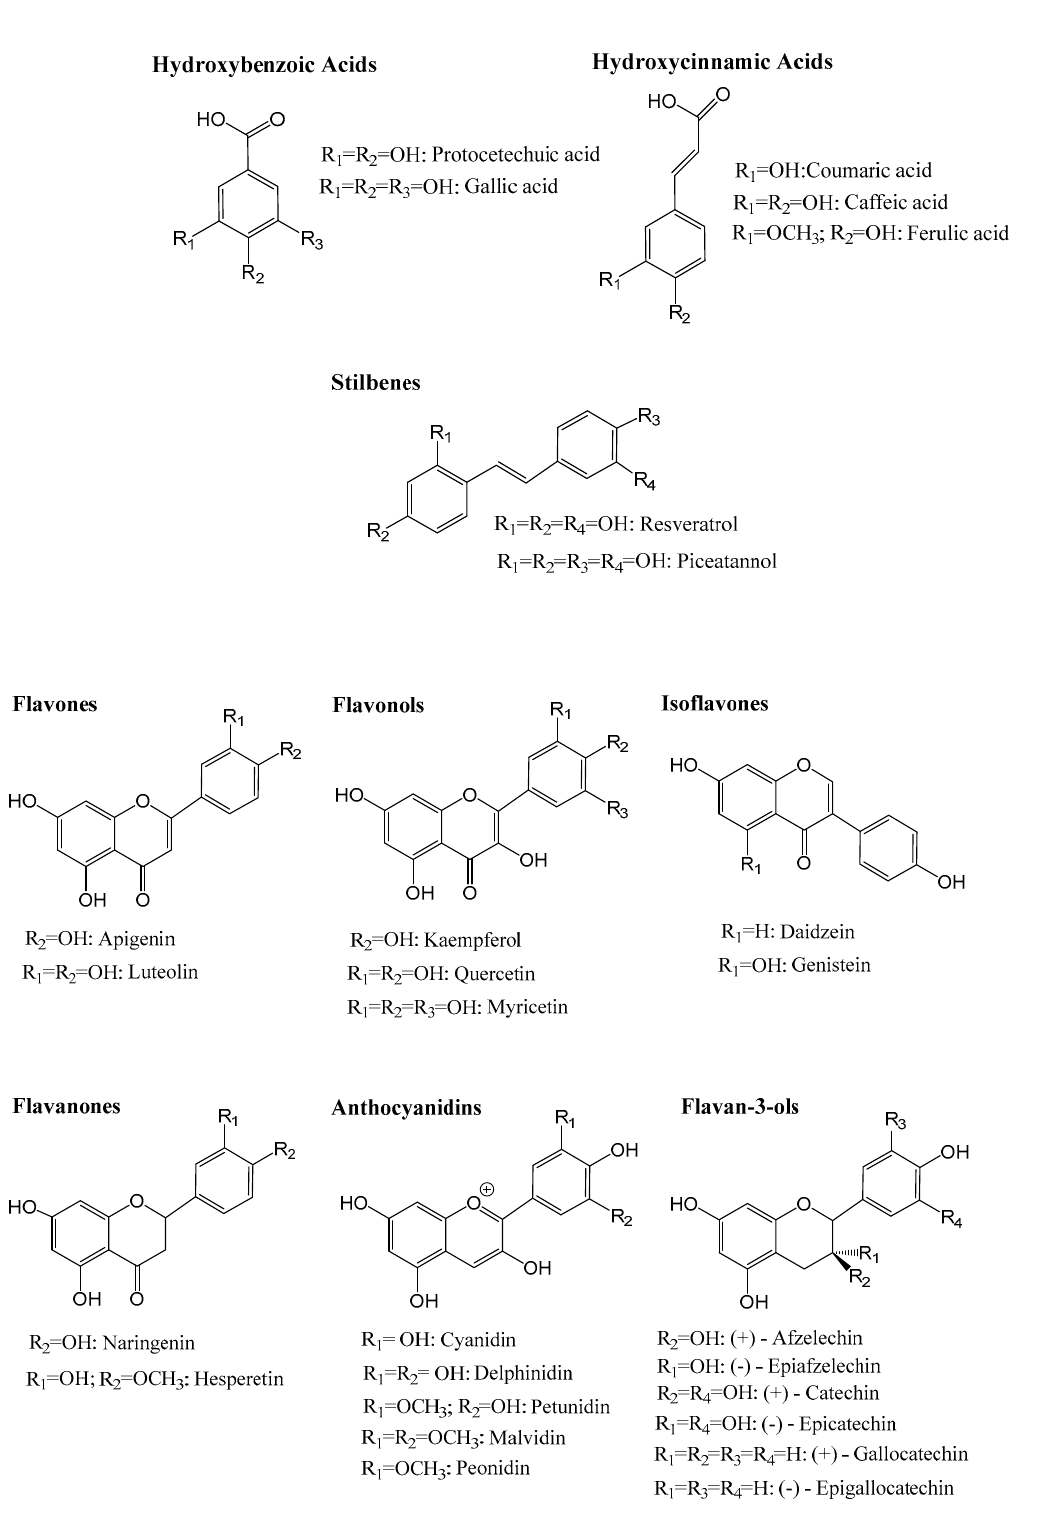
Figure 1. Chemical structure of the major nonflavonoids and flavonoids subclasses